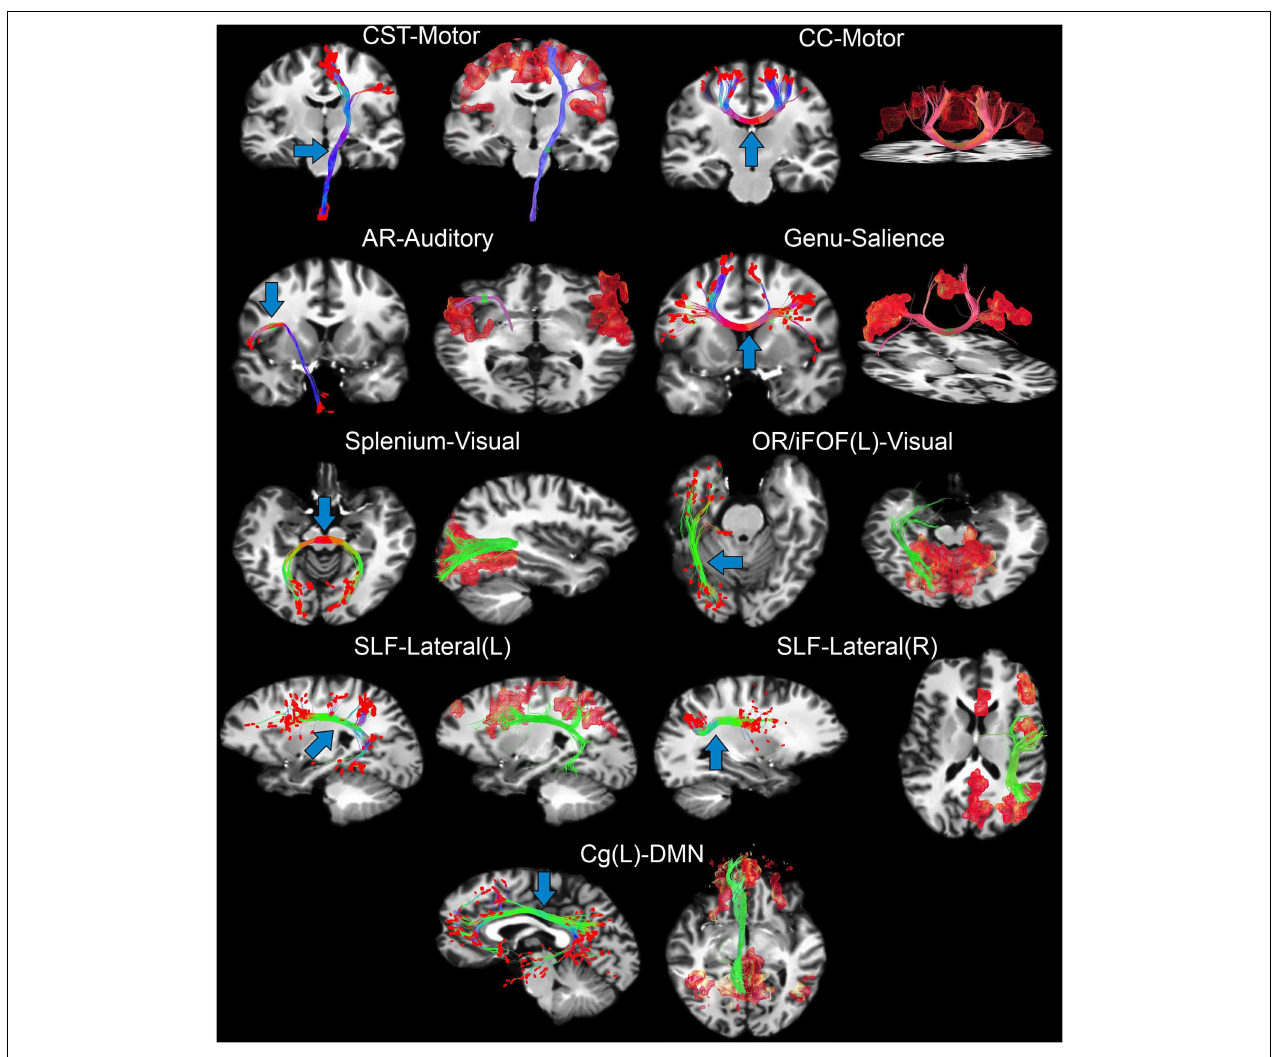
the salience network ( z > 4.2), CC-splenium and the visual network ( z > 5.0), OR-left and the visual network ( z > 4.4), left and right SLF for the lateralized networks ( z > 4 . 6 ), Cg and the DMN ( z > 4.1). Blue arrows show where tractography seed-ROI was positioned. Note how functional connectivity extends far beyond the white matter seed points for the motor, auditory and DMN